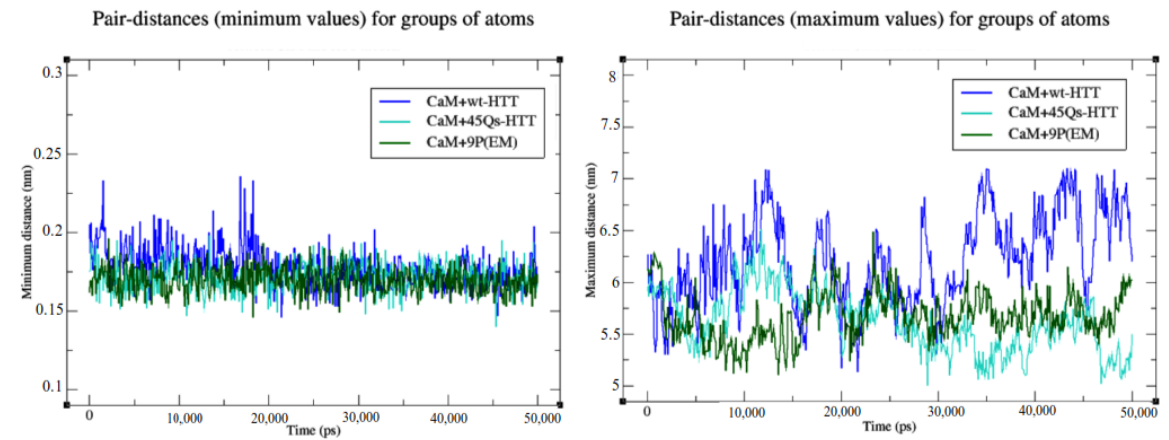
Figure 12. Pairwise distances between CaM and the HTT